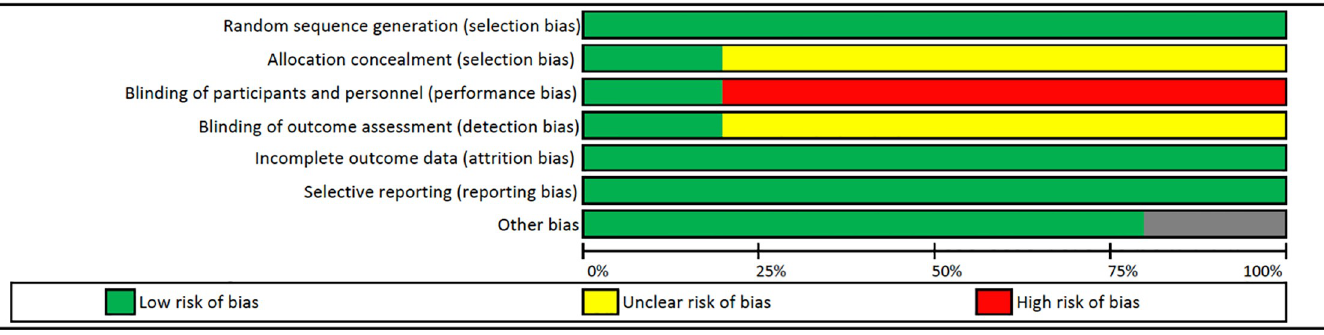
Fig 2. Risk of bias